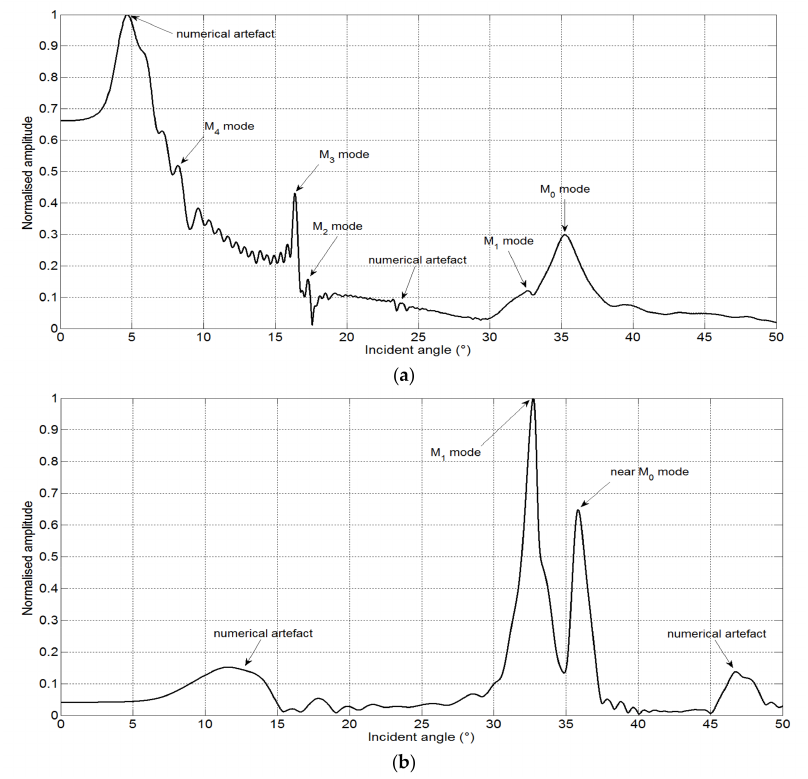
Figure 7. ( a ) Spectral representation of the modes detected at 20 MHz with the classical V ( z ) trans- ducer; ( b ) corresponding spectra obtained with the segmented V ( z )